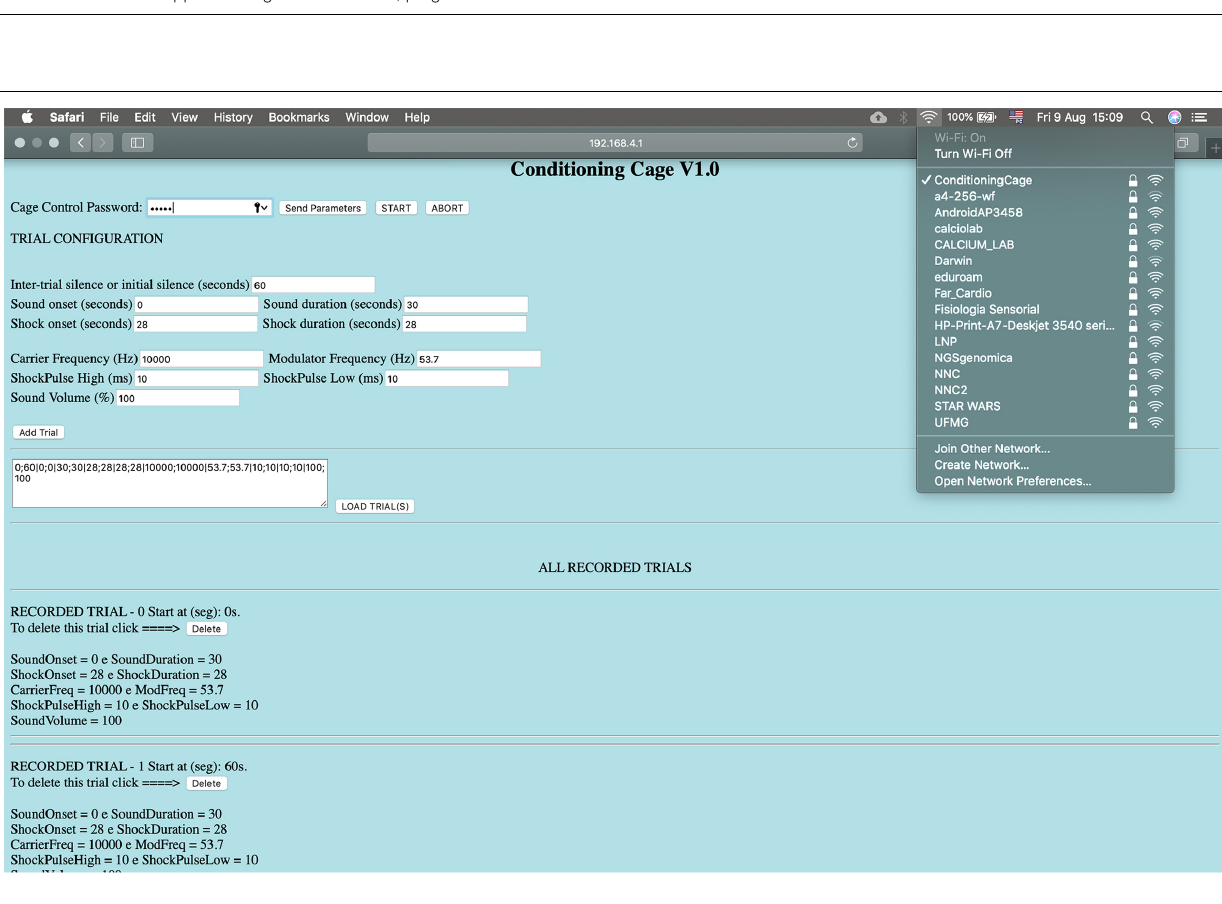
Frontiers in Neuroscience |